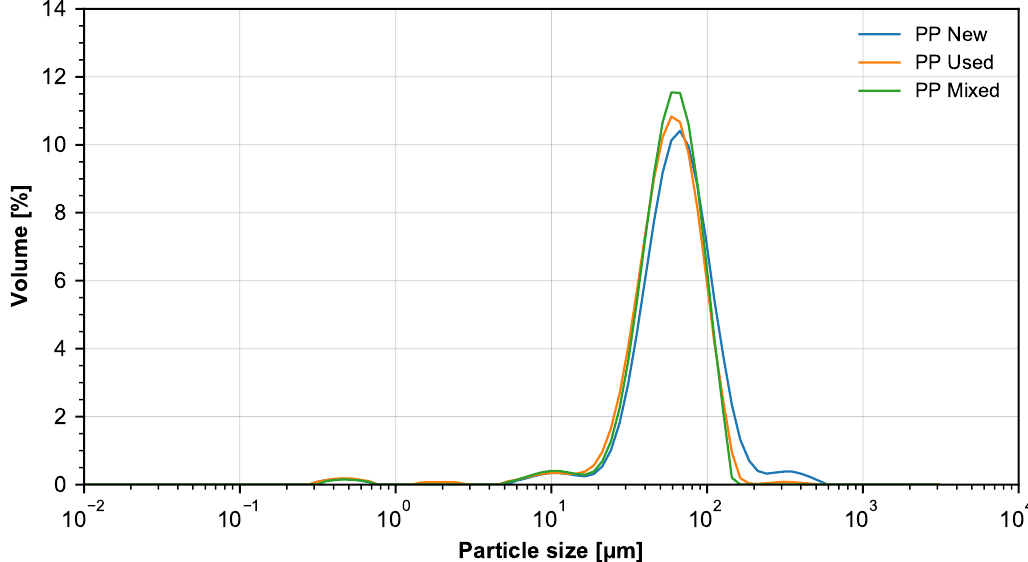
Figure 1. The histograms of the size distribution of new, used and mixed PP